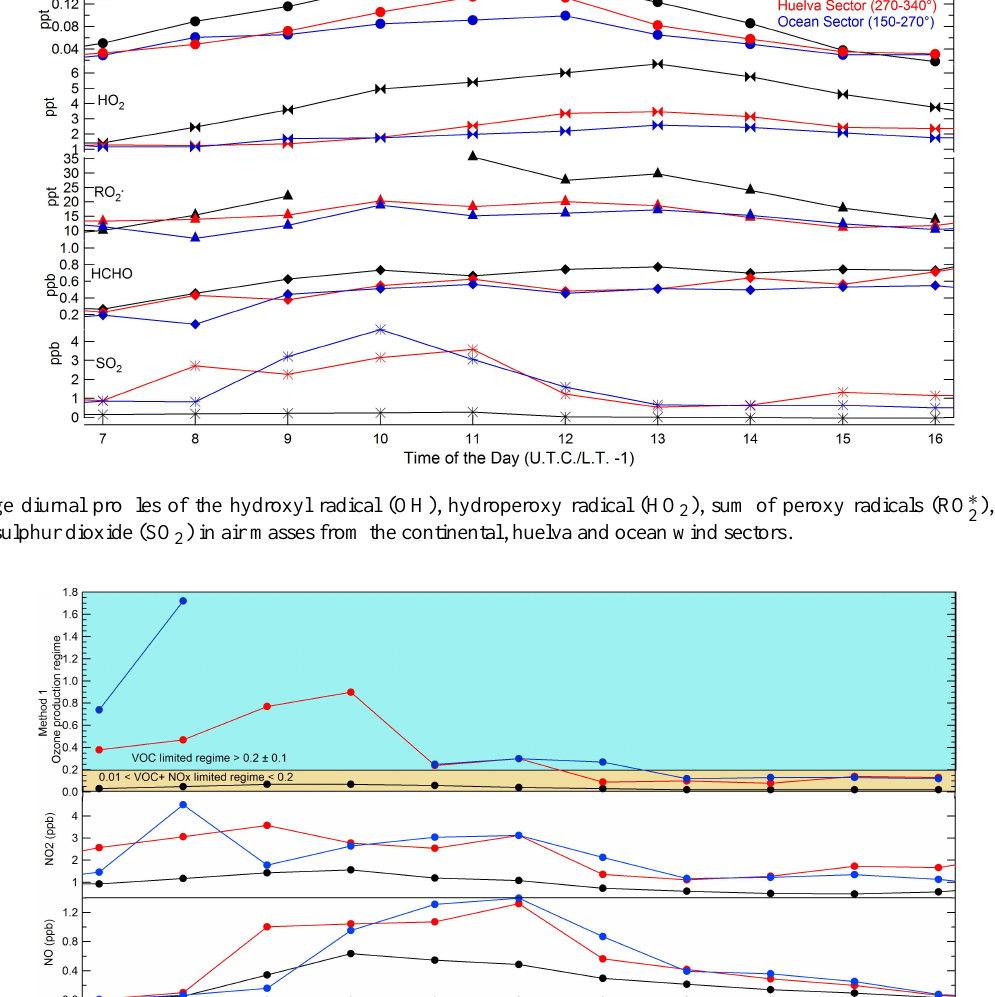
Fig. 5. Instantaneous diurnal ozone production regime for each of the three air mass sectors, namely, Continental (black markers), Huelva (red markers), and Ocean (blue markers) using Method 1 (top panel) and average diurnal NO x (NO, NO 2 ) mixing ratios (bottom